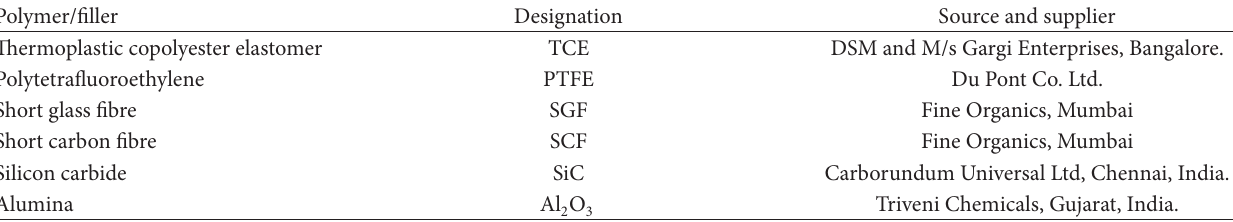
Table 1: Source and supplier details of materials used in the present investigation.